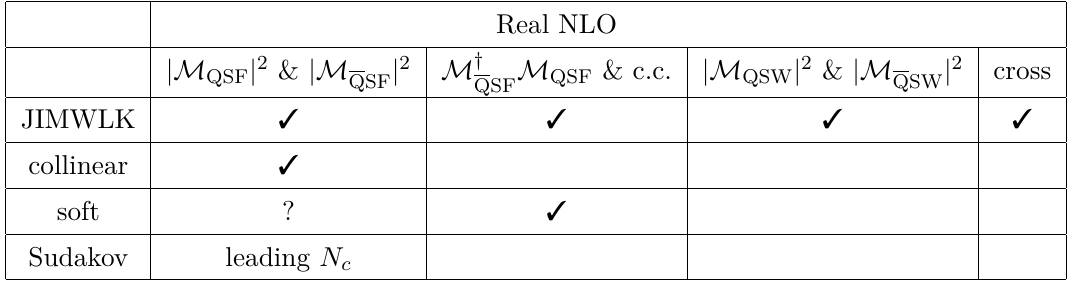
Table 1 . Overview of the divergencies and large logarithms encountered in our calculation, for the different real NLO contributions to the cross section. In the column ‘cross’, all cross terms are meant between the gluon emissions before and after the shockwave, from the quark or from the antiquark, i.e. the interference between M , M , M , M . Terms involving a real QFS QSW QFS QSW instantaneous gluon emission are strictly finite and do not contribute to the Sudakov logarithms at our accuracy. In this work, we do not attempt to analyze the Sudakov double logarithms beyond the large- N limit. Moreover, in our regularization scheme, it is not always possible to unambiguously c distinguish soft from rapidity divergences. The question mark indicates this is the case for |M 2 QSF | and |M | 2 . The only certainty is that these two diagrams combine with FSIR (table 2) into a QSF contribution to the cross section that has rapidity divergences only, see also section